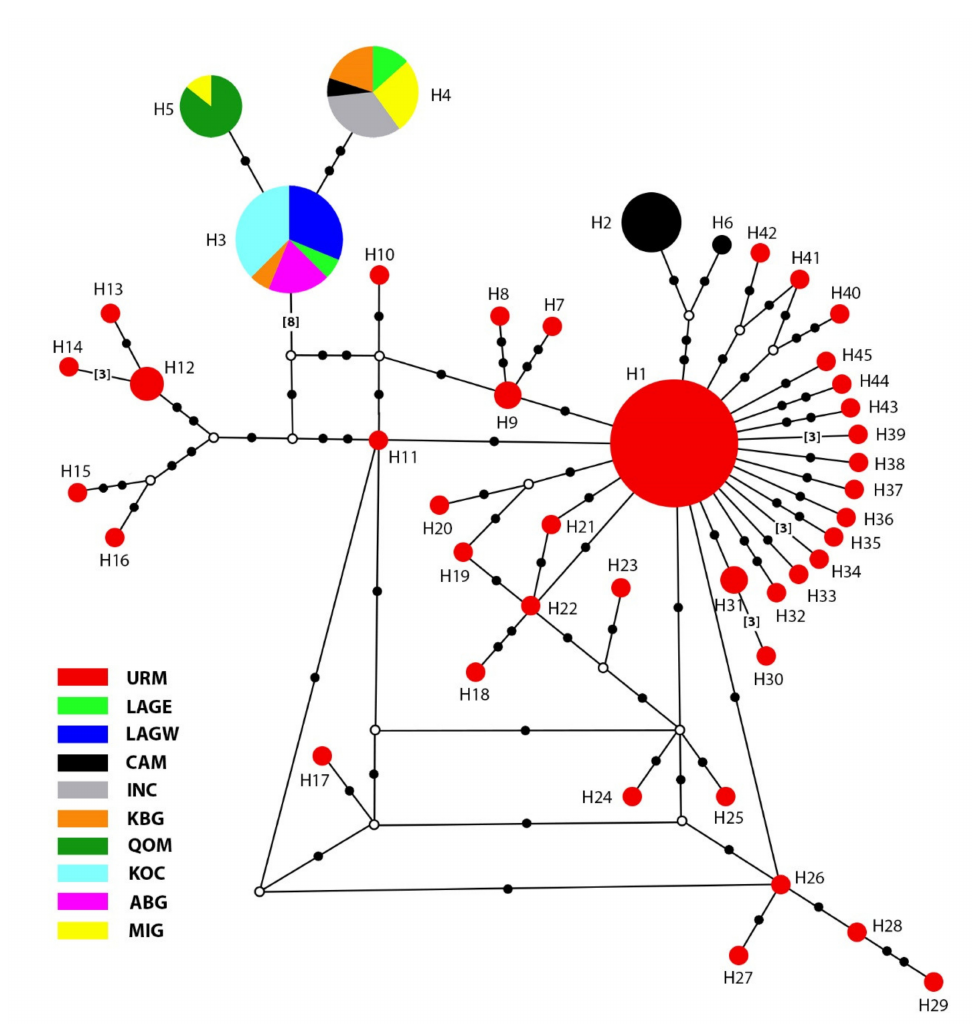
Figure 3. The relationship of COI haplotypes distribution among native populations (abbreviations listed in Table 1).